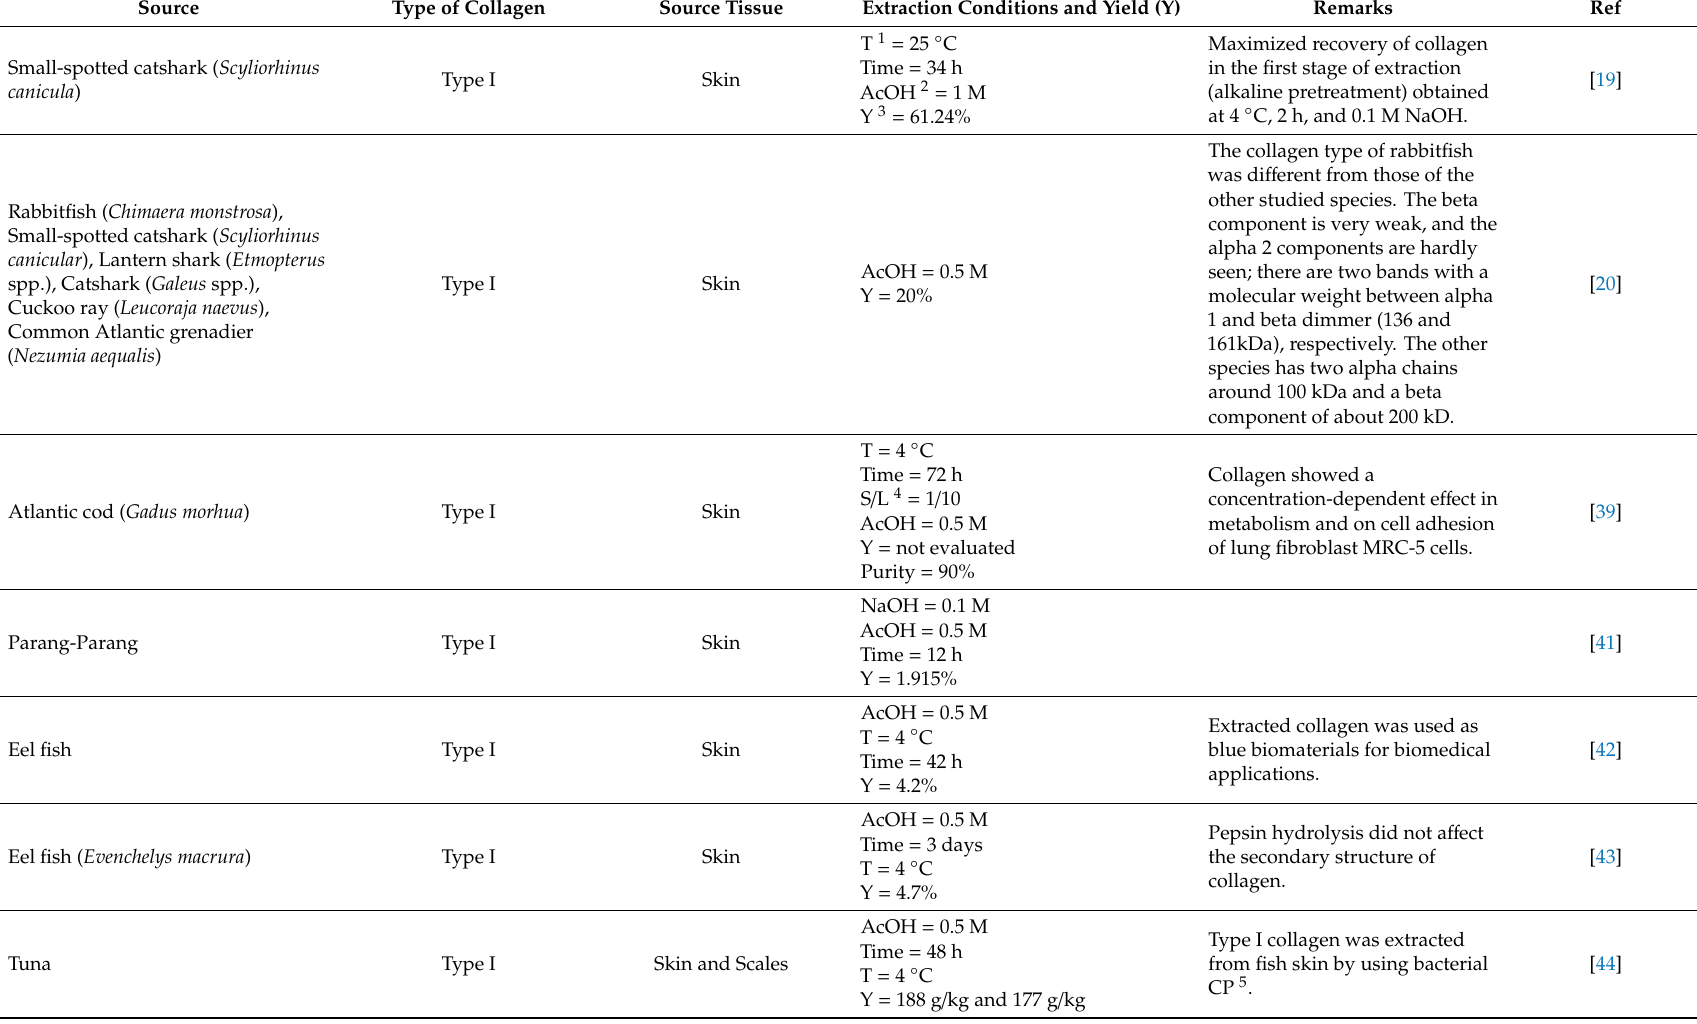
Table 1. A summary of recent collagen isolation and characterization from di ff erent fish (vertebrate animals) and invertebrate